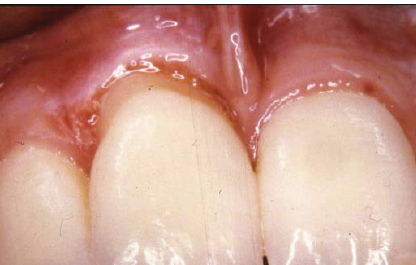
Figure 3: Patient 1: gingival retraction at the right maxillary central incisor after acute gingivitis in